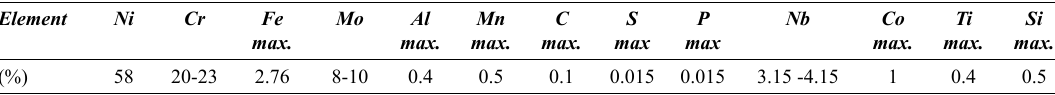
Table 1. Alloy 625 chemical composition (%) Element